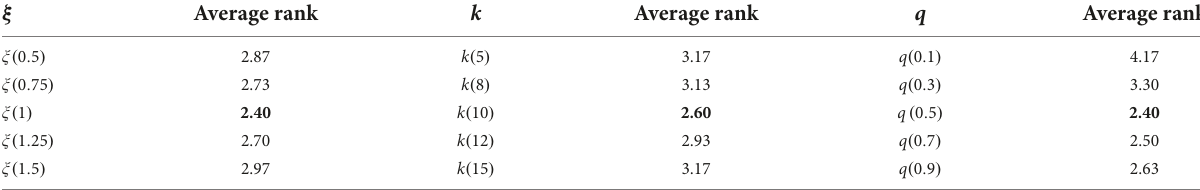
TABLE 2 Values of important parameters in EACOR.